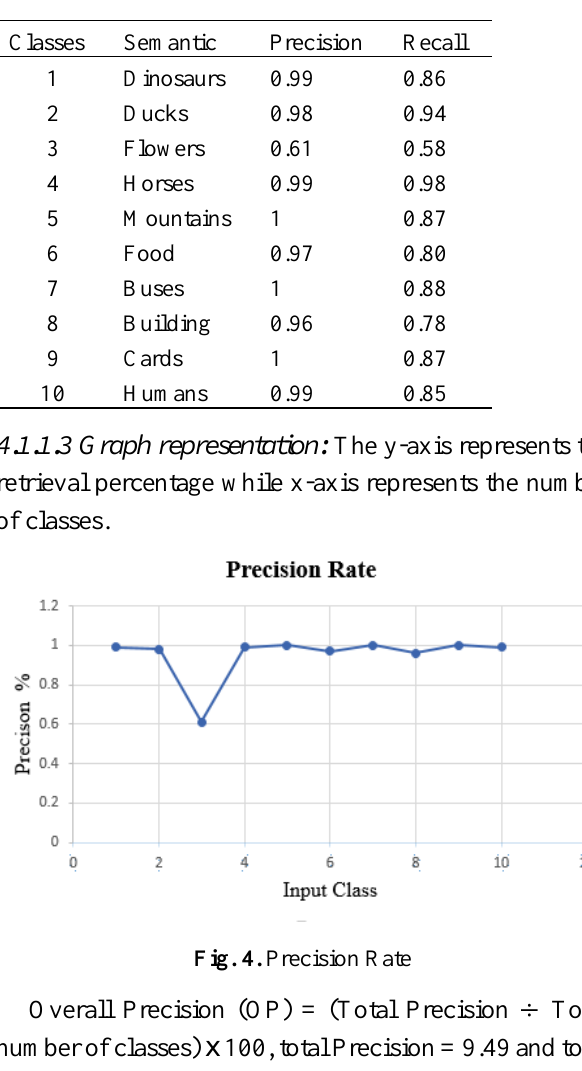
Evaluation of Precision and Recall Measurements